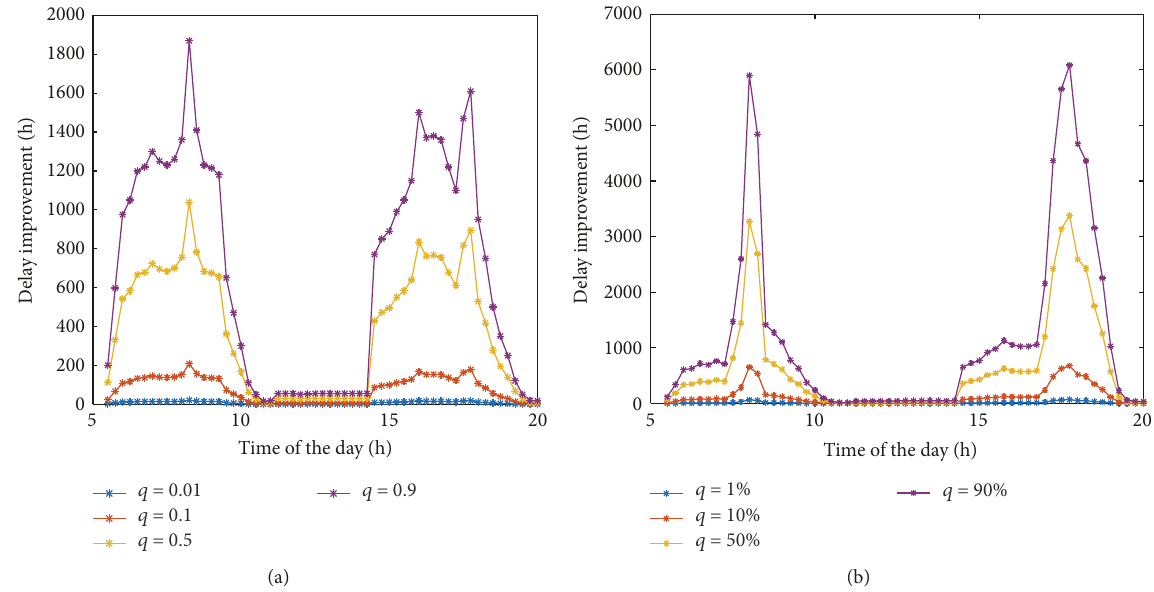
Figure 11: Effect of smart routing using perfect information for different penetration rates on the average day (a) and for February 5, 2015.